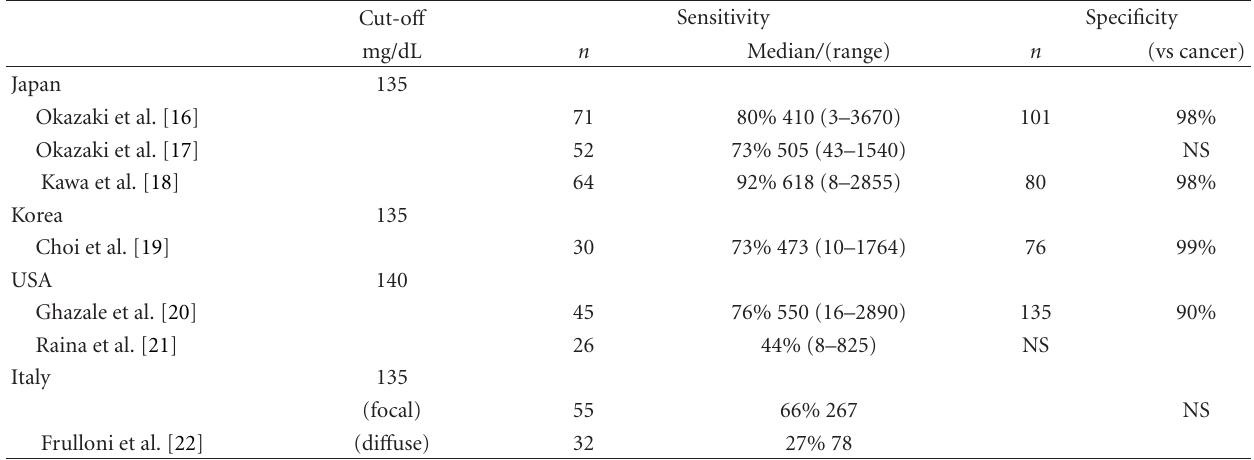
Table 6: Sensitivity and specificity of serum levels of IgG4 in patients with type 1 AIP.